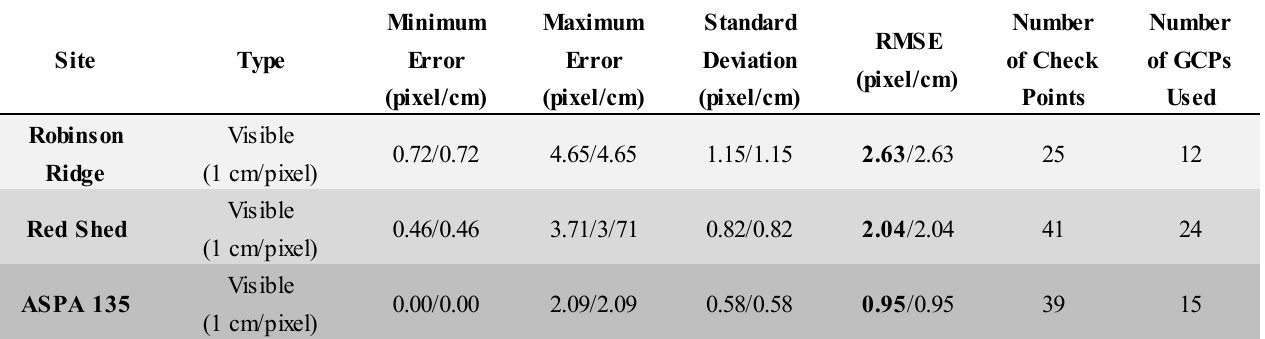
Table 2. Spatial accuracy of orthomosaics for each sensor as measured against check